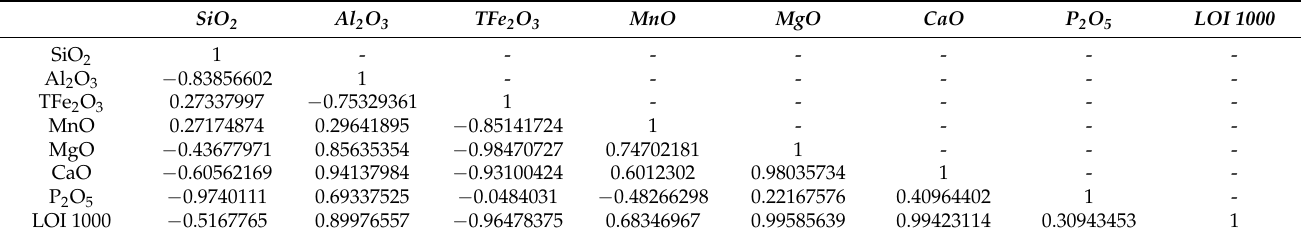
Table 4. Pearson’s correlation matrix for major element oxides of carbonate-oxide facies BIF. SiO